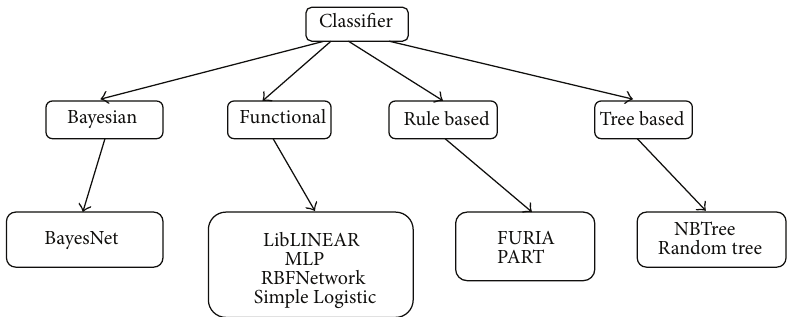
Figure 9: Classifier hierarchy considered for present